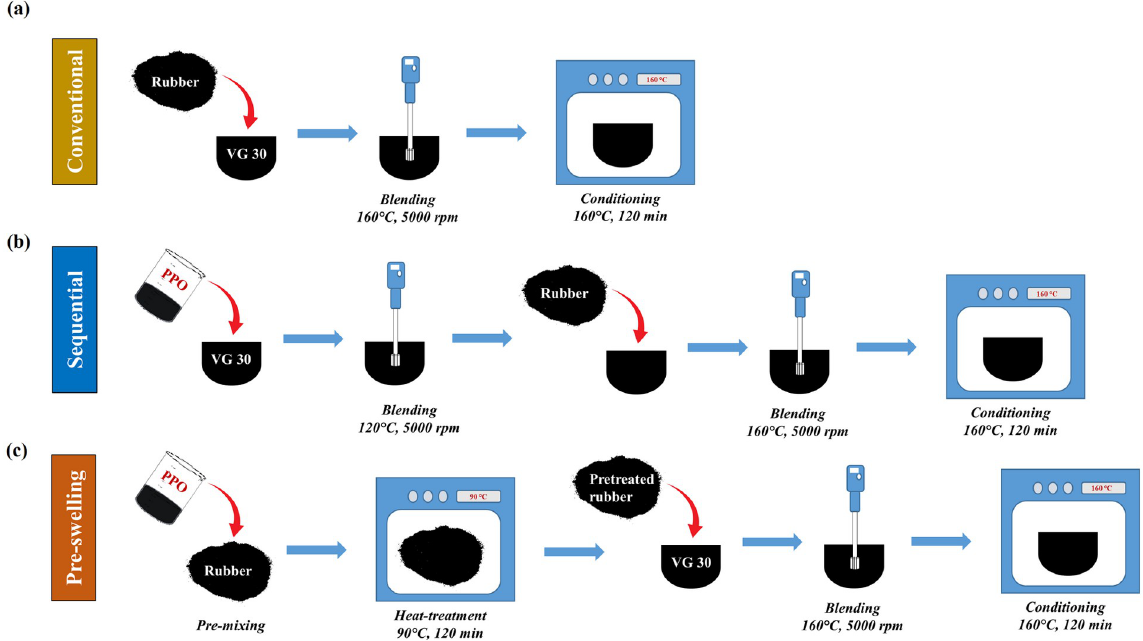
Fig 3. Schematic illustration for the formulation of composite asphalt